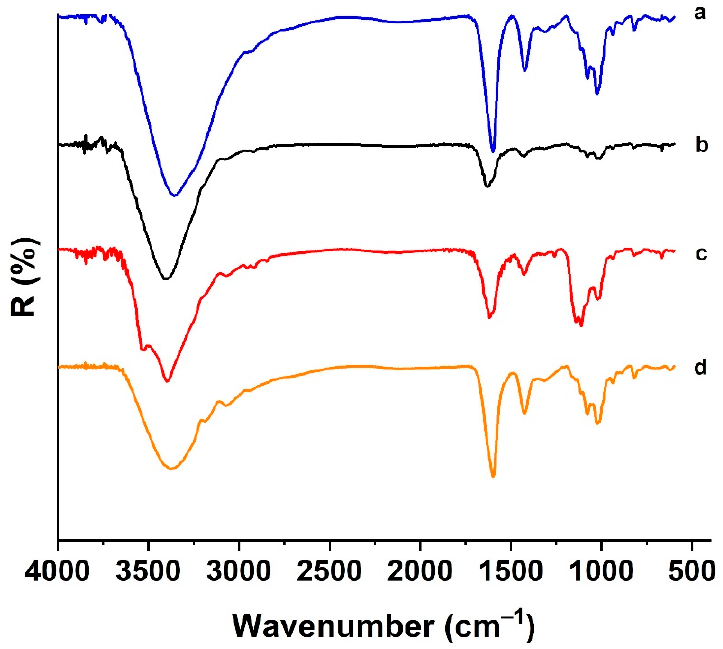
Figure 2. ( a ) Optical, ( b ) SEM, and ( c ) AFM images of CUR@H ALG (top) and CUR@H ALG-GO (bottom) showing: ( a ) the typical orange color of CUR loaded into the polymer networks; ( b ) the homogeneous incorporation of GO into the hybrid materials; ( c ) the presence of the GO sheet emerging from the hydrogel surface.